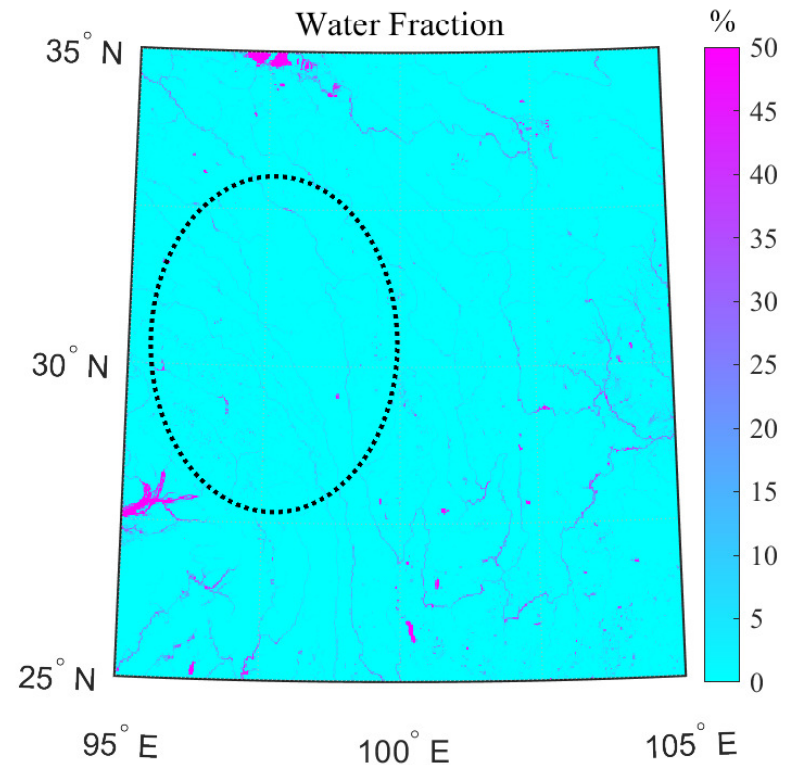
Figure 6. Water fraction over the region of [25,35] ◦ N and [95,105] ◦ E (corresponding to Figure